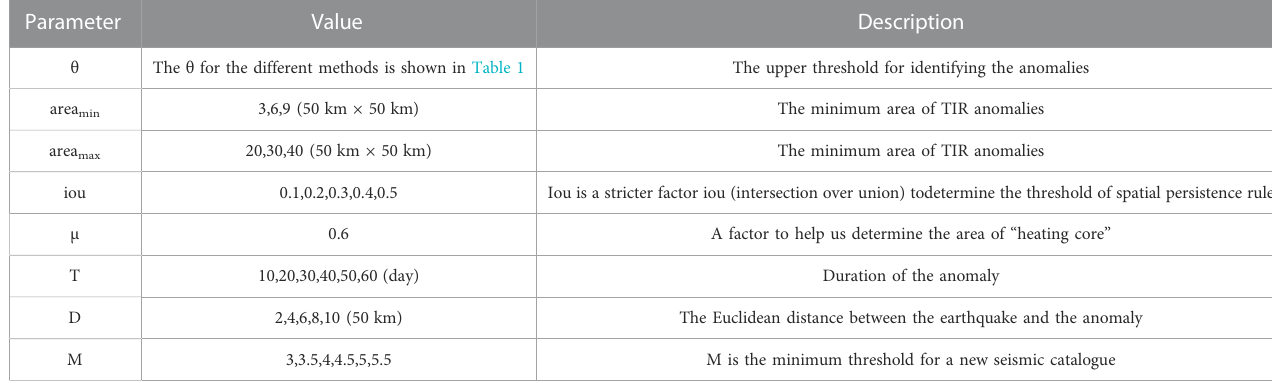
TABLE 3 Parameters to extract DTIRs and determine the correspondence between DTIRs and